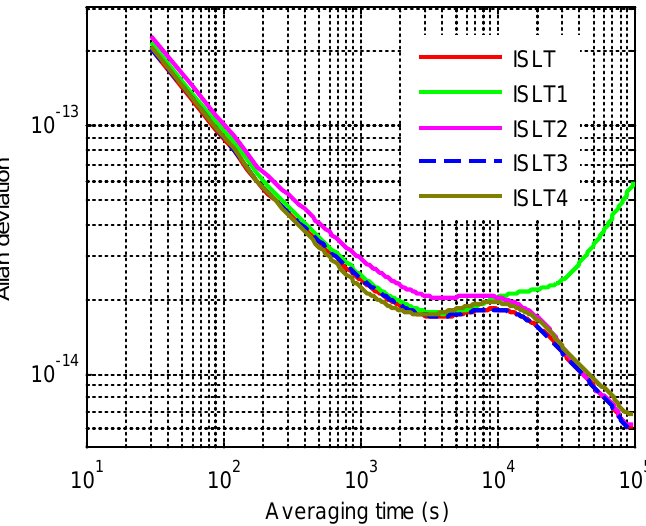
Table 3. The ensemble of satellite clocks that kept the ISLT.